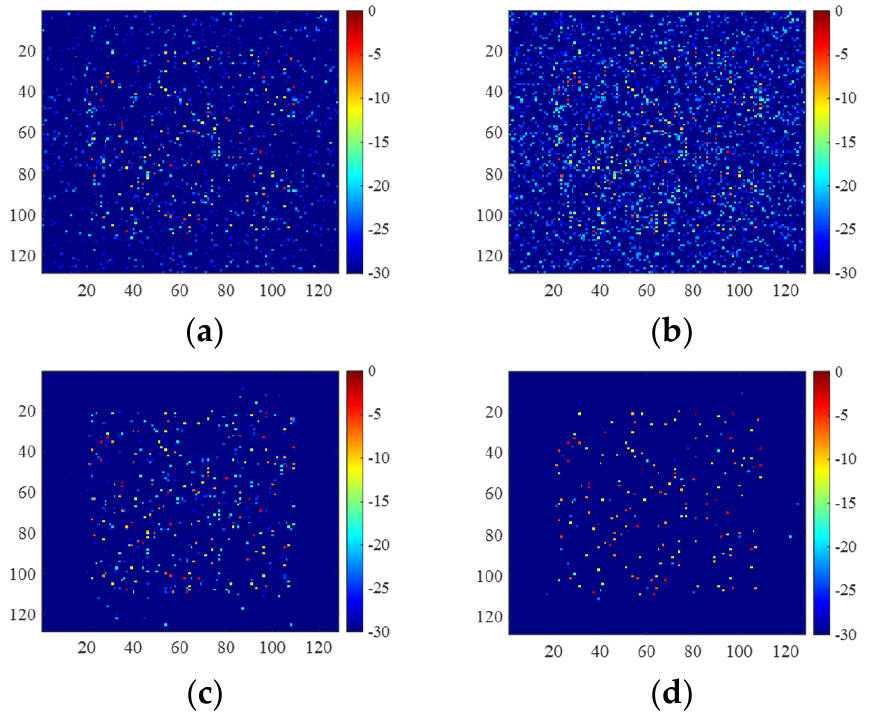
Figure 11. Images of the incomplete range data with data missing pattern shown in Figure 8c, which are obtained by ( a ) 2D ‐ FISTA, ( b ) untrained 2D ‐ ADN, ( c ) UNet, and ( d ) trained 2D ‐ ADN. Table 4. Quantitative performance evaluation for the incomplete range simulation data.